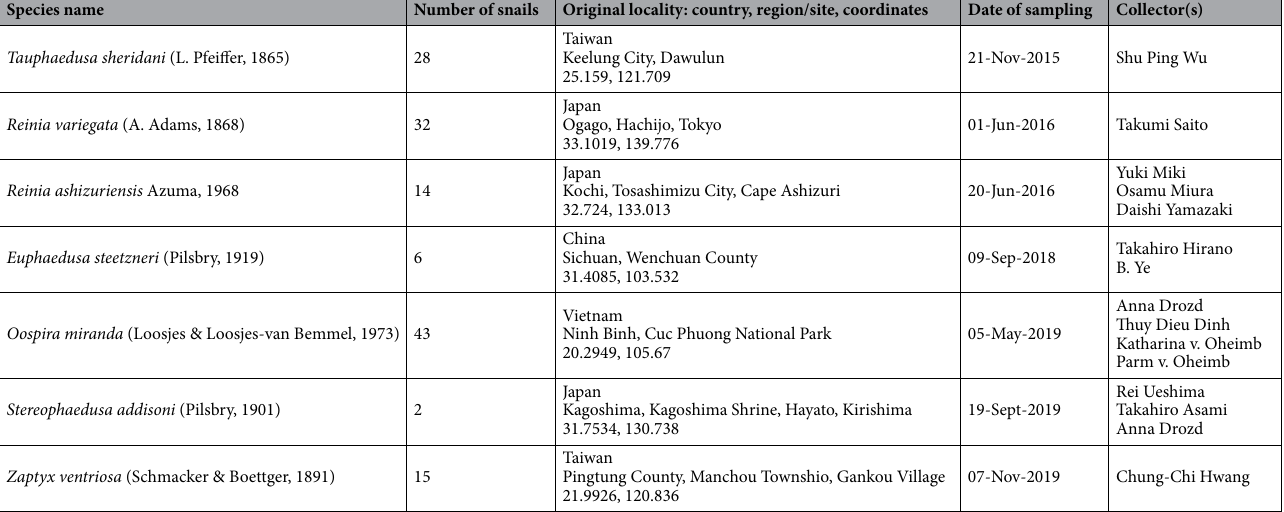
Table 2. Viviparous Phaedusinae species kept in the laboratory: scientific name, number of wild-collected individuals at the start of laboratory colony, original localities and sampling